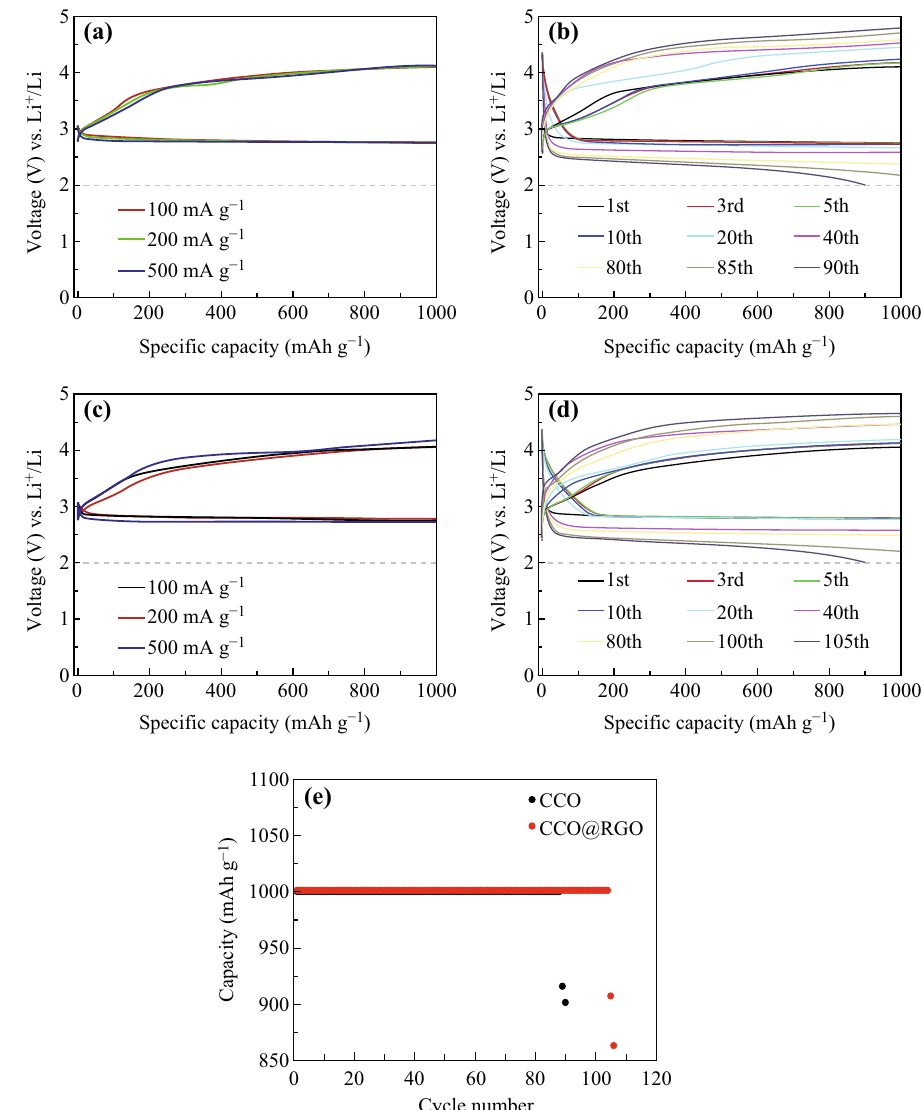
Fig. 4 a , c Galvanostatic discharge and charge curves of the CCO and CCO@rGO cathodes at different current densities (100, 200, and 500 mA g - 1 ). b , d Discharge/charge curves of the CCO@rGO and CCO cathodes. e Cyclic stability of the LOBs with CCO@rGO and CCO cathodes. All the discharge and charge processes are measured via a limited capacity of 1000 mAh g -